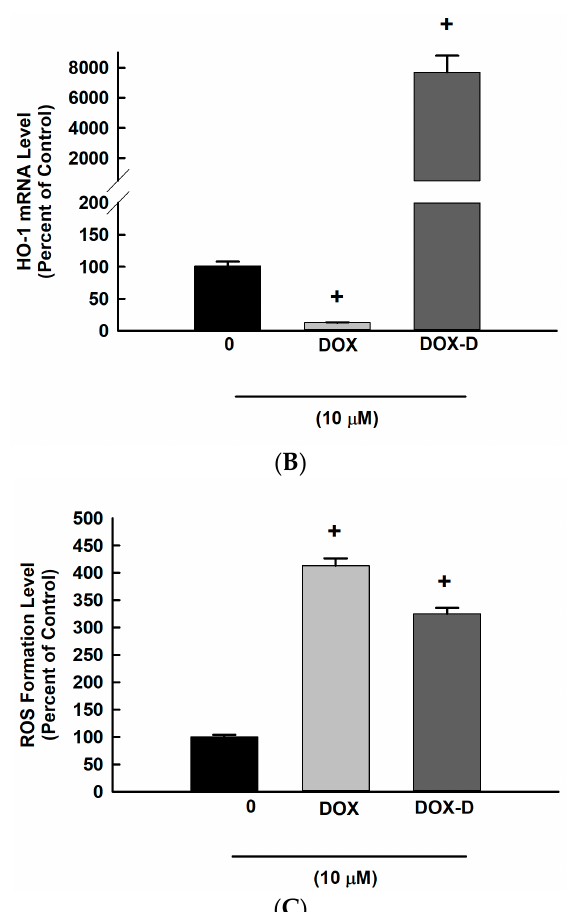
Figure 6. Effect of DOX and DOX-Vit D on the oxidative stress. MG63 cells were treated for 24 h with 10 µM DOX and DOX-Vit D. Thereafter, total RNA was isolated using TRIzol reagent, and the mRNA levels of ( A ) NQO-1 and ( B ) HO-1 were quantified using real time-PCR and normalized to a β -actin housekeeping gene. ( C ) MG63 cells were treated for 24 h with 10 µM DOX and DOX-Vit D then, cells were incubated with DCF-DA (10 µM) for 1 h. DCF formation was measured fluorometrically using excitation/emission wavelengths of 484/535 nm. The results are presented as the mean ± SEM ( n = 6). + p < 0.05 compared to control.